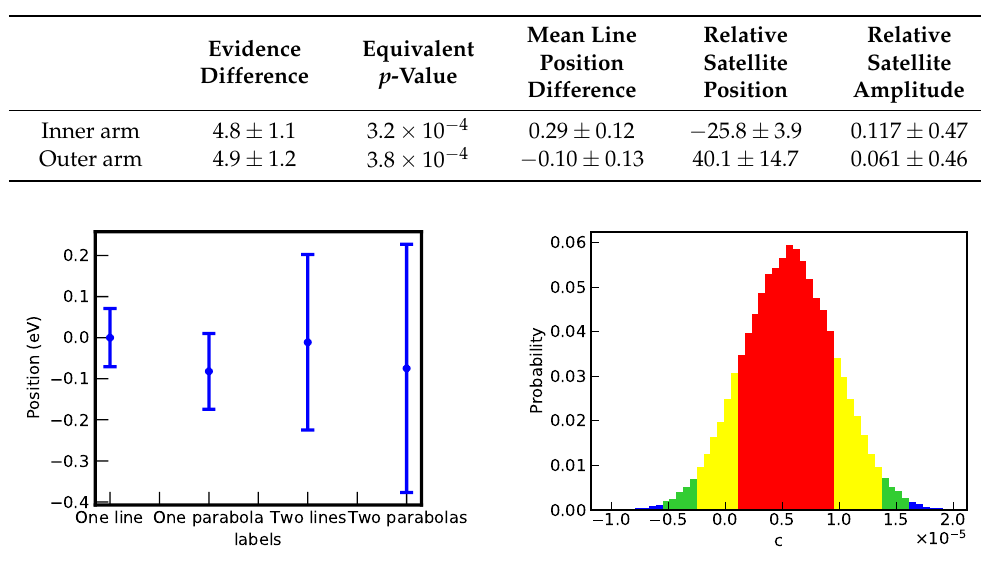
Table 1. He-like uranium line data analysis selected outputs obtained from the evaluation of the Bayesian evidence of the spectra from the two spectrometers.